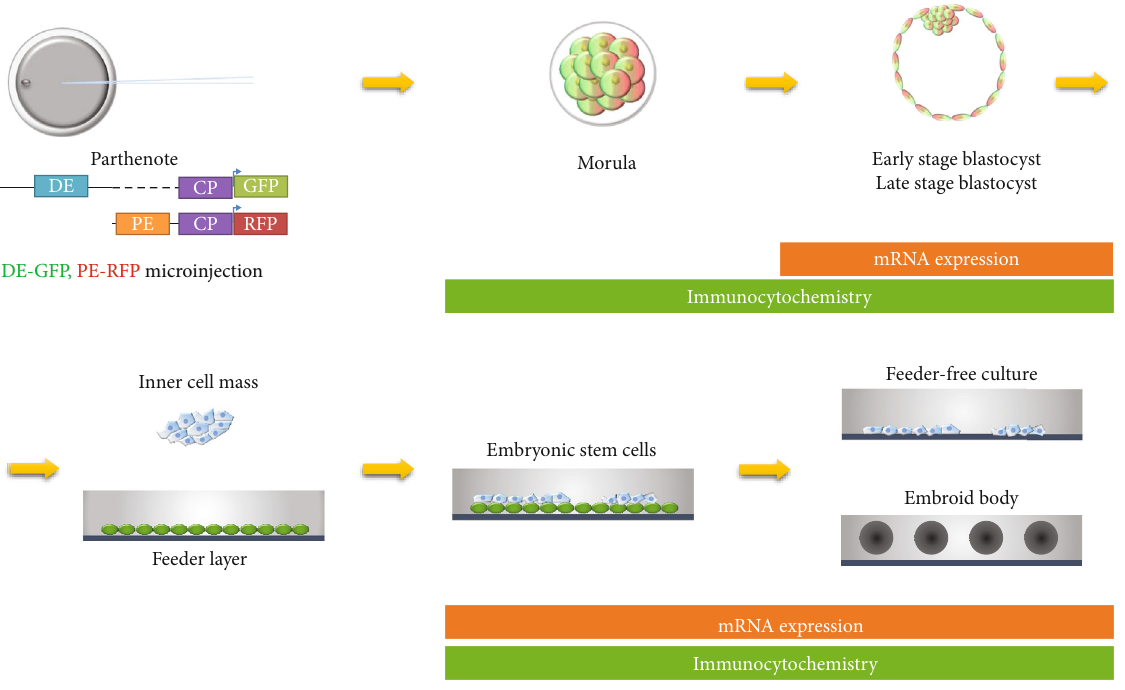
Figure 1: Schematic overview of the study on the porcine OCT4 reporter system during early embryo development and embryonic stem cells. Porcine embryos were microinjected with the p OCT4 - Δ PE-eGFP (DE-GFP) containing a distal enhancer and core promoter and p OCT4 - Δ DE-DsRed2 (PE-RFP) containing a proximal enhancer and core promoter. Hatched parthenogenetic blastocysts were seeded on feeder cells composed of mitotically inactivated mouse embryonic fi broblasts (MEFs). Protein and mRNA expression in morula, blastocysts, embryonic stem cells, and embryoid body was analyzed using immunocytochemistry and quantitative real-time